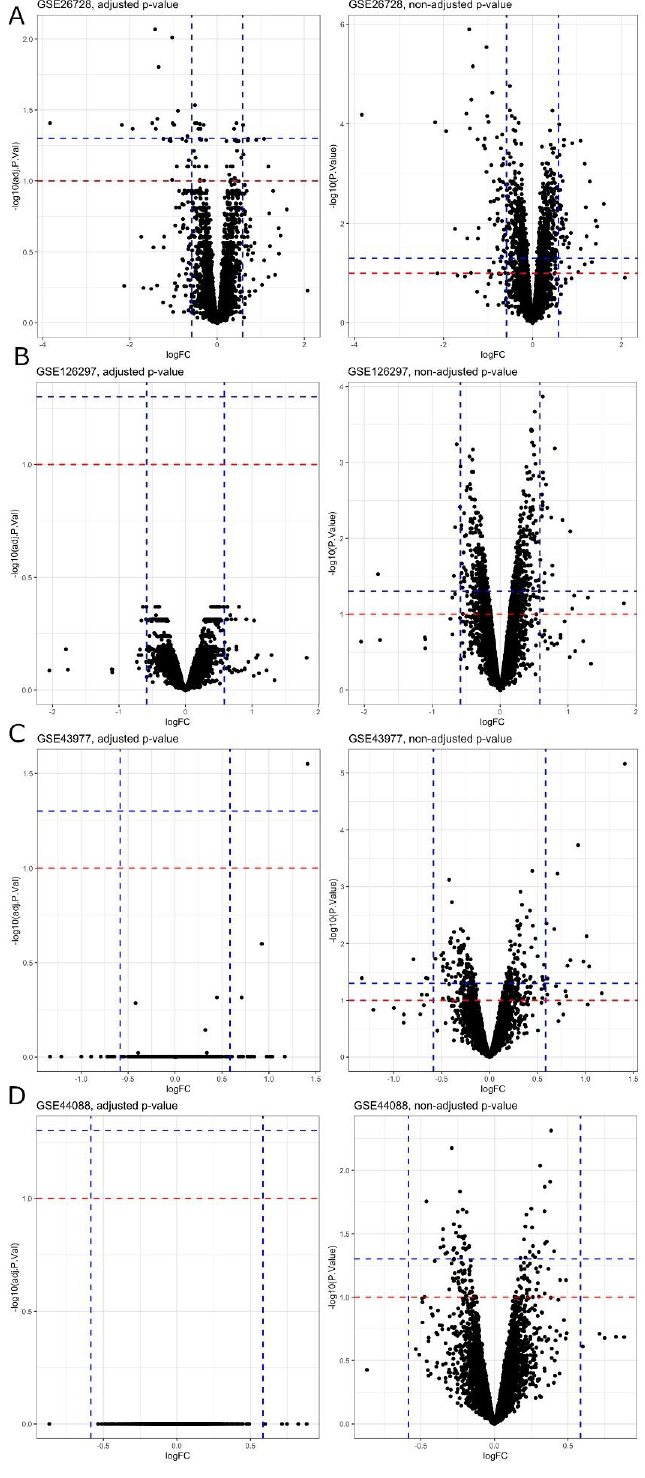
Figure 1. Volcano plots of differential expression analyses, using adjusted p -values (left column) and non-adjusted p -values (right column), for ( A ) GSE26728, ( B ) GSE126297, ( C ) GSE43977, and ( D ) GSE44088 datasets. Dashed blue lines are used to designate p -value of 0.05, dashed red lines for p -value of 0.1. Only GSE26728 has differentially expressed genes with respect to both adjusted and non-adjusted p -values. Other datasets have differentially expressed genes with respect to non-adjusted p -values